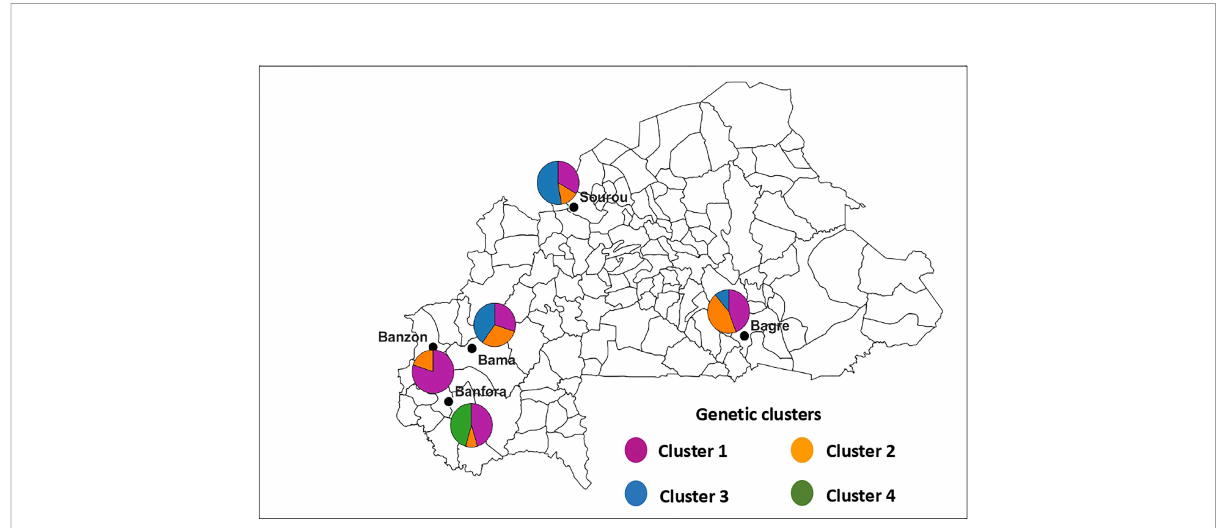
FIGURE 4 Geographic distribution of the four genetic clusters of Bipolaris oryzae in Burkina Faso. The size of sectors is proportional to the proportion each cluster de fi ned by DAPC in each area. Cluster 1 (n = 27 isolates), Cluster 2 (n = 13 isolates), Cluster 3 (n = 16 isolates) and Cluster 4 (n = 5